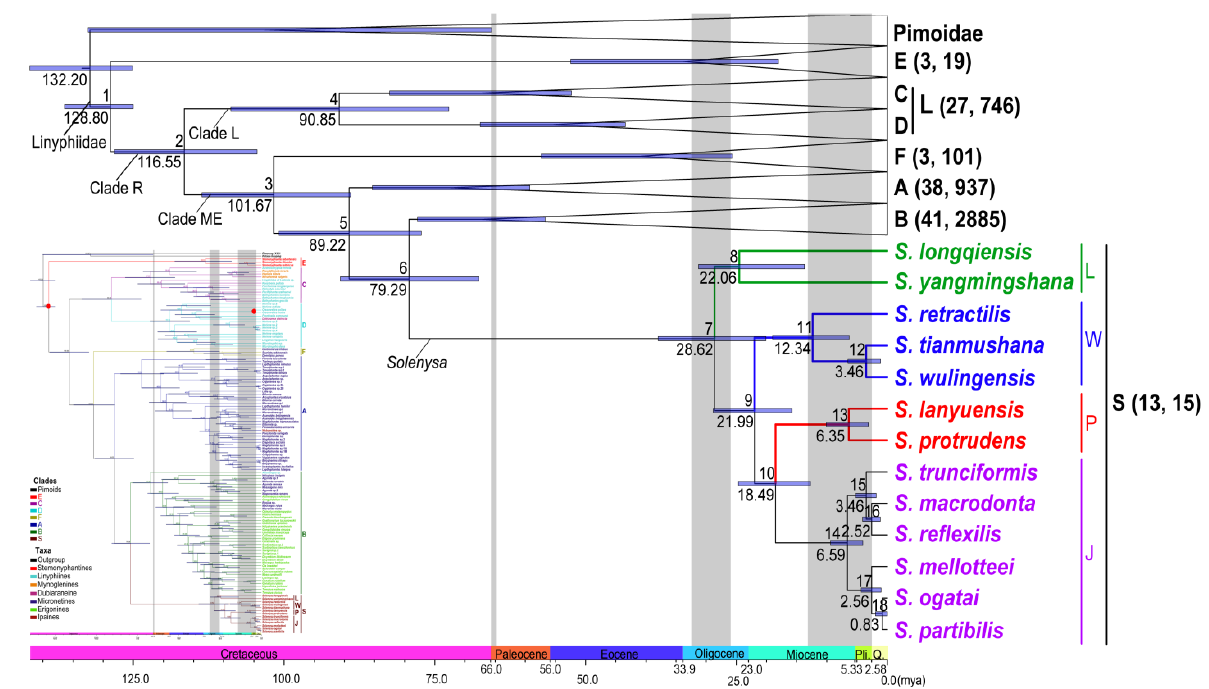
Figure 3. Chronogram of linyphiids. Branches and taxon names in color show the four clades within Solenysa . Branches of other six major clades collapsed. In the complete chronogram shown in microimage, two red dots indicate calibration points. Numbers in parentheses after clade names refer to the sampling numbers of the clades and species numbers represented, respectively. Numbers above branches label the divergence nodes of the seven major clades within linyphiids and internal nodes within Solenysa . Values below branches show divergence time of nodes, and node bars show confidence intervals. Three grey belts refer to K-T boundary, early and middle Oligocene, and middle Miocene and Pliocene, respectively.